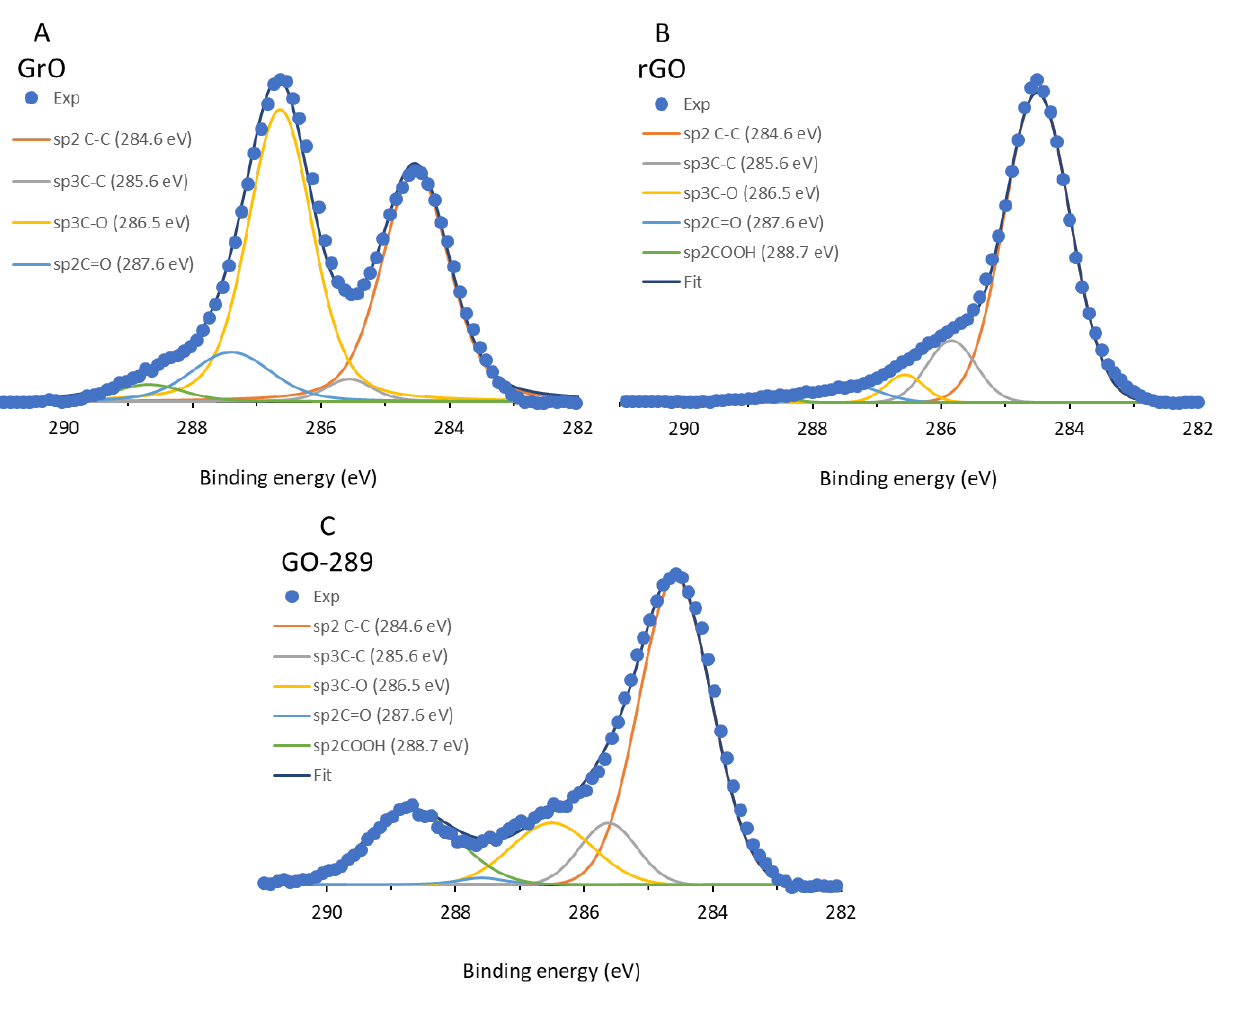
Figure 3. C1s XPS fitting plots for ( A ) GrO, ( B ) rGO and ( C ) GO-COOH. Figure 3A shows the XPS C1s spectrum for GrO, which is typical for a graphite oxide; the main peak is located at 286.7 eV. Interpretations of which functional groups are